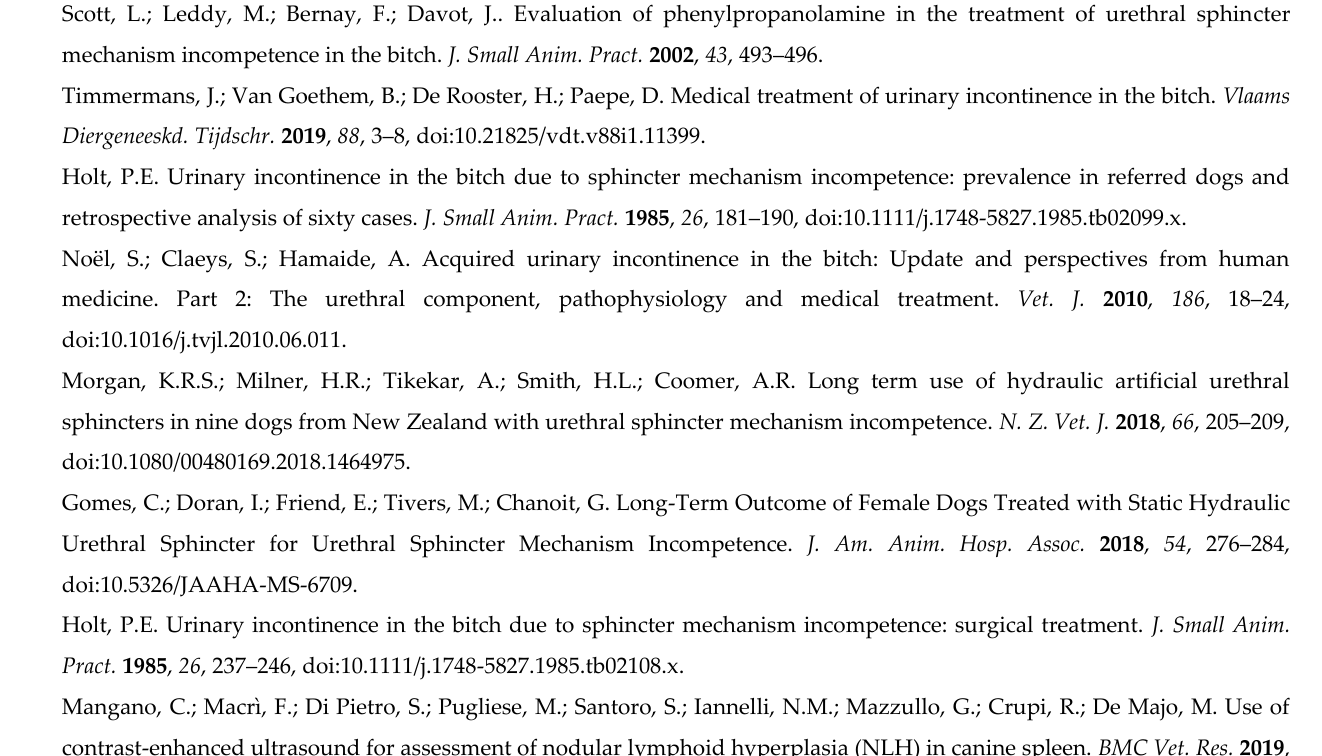
Supplementary Materials: Figure S1: The gross aspect of the splenic hematoma in a 14-years old spayed mixed German Shepherd bitch, after splenectomy, Table S1: Pre-operatory and post-operatory biochemi- cal and hematological values, Table S2: Pre-operatory and post-operatory blood gases values (i.e., venous